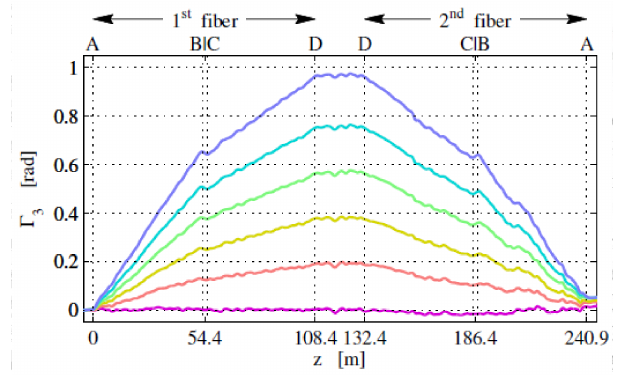
Figure 28. Accumulated Faraday rotation for different current intensities (reprinted from Palmieri et al. [65] with permission of OSA; copyright (2015)).